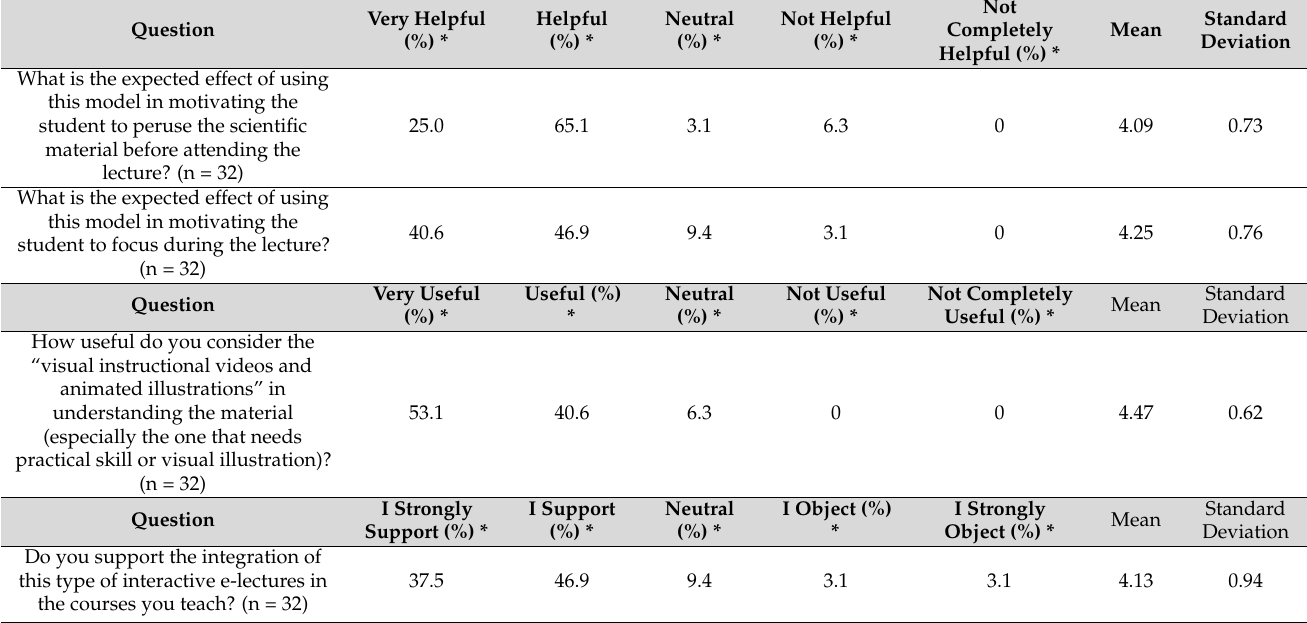
Table 5. Evaluation of using e-lectures as a model for flipped learning by faculty.